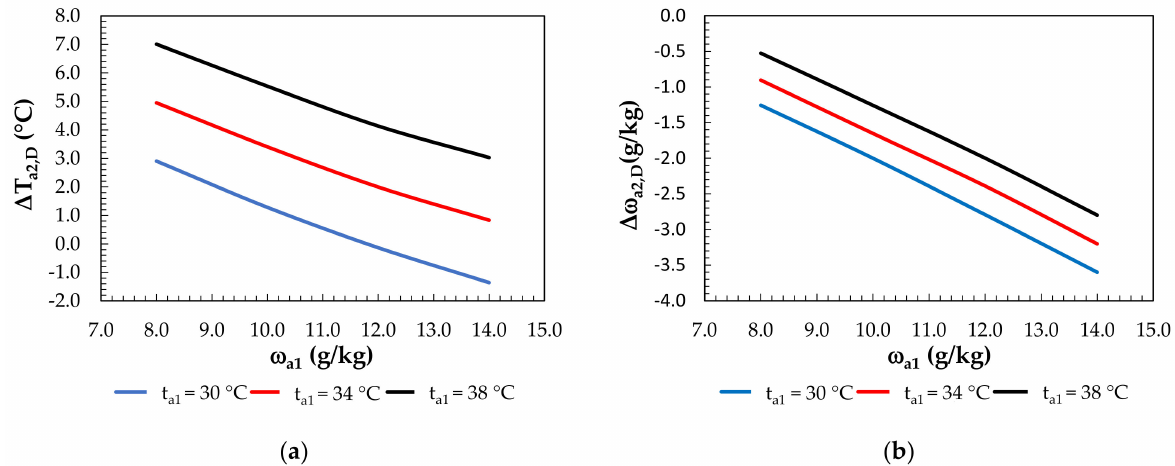
Figure 10. Effect of the inlet air humidity ratio for constant inlet air temperatures under air dehumid- ification: ( a ) on air temperature differences; ( b ) on the change in the humidity ratio. The change in the humidity ratio ranged from 0.5 g/kg (for t a1 = 38 ◦ C and at ◦ C and at ω ω a1 = 8 g/kg) to 3.6 g/kg (for t a1 = 30 a1 = 14 g/kg). In the air dehumid- ification process, the highest temperature drop occurred at the lowest humidity ratio ( ω a1 = 8 g/kg) and highest temperature (t a1 = 38 ◦ C). This was due to the fact that the lowest solution temperature was obtained in the regeneration process for this humidity ratio. The higher the humidity ratio is, the higher the solution regeneration temperature required must be. For the evaporative cooling (Figure 11), the temperature drop ranged from 5.2 ◦ C (at t a1 = 30 ◦ C, ω a1 = 14 g/kg) to 12.3 (at t a1 = 38 ◦ C, ω a1 = 8 g/kg), while the increase in the humidity ratio ranged from 2.3 g/kg (at t a1 = 30 ◦ C, ω a1 = 14 g/kg) to 5.6 g/kg (at t a1 = 38 ◦ C, ω a1 = 8 g/kg).